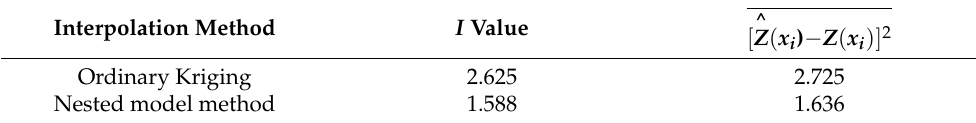
Figure 8. Distribution of Weigan River Basin oasis water system. Figure 9 is the profile of total salt content of two rivers. It can be seen from the figure that the soil salt content increases with the trend of the river, showing a distribution of low in the upstream and high in the downstream. Topography is an important factor that affects the soil properties and determines its changes [36,37]; these high salinity areas are located in the lower southeast of the study area and the edge of the oasis, as shown in Figure 10.